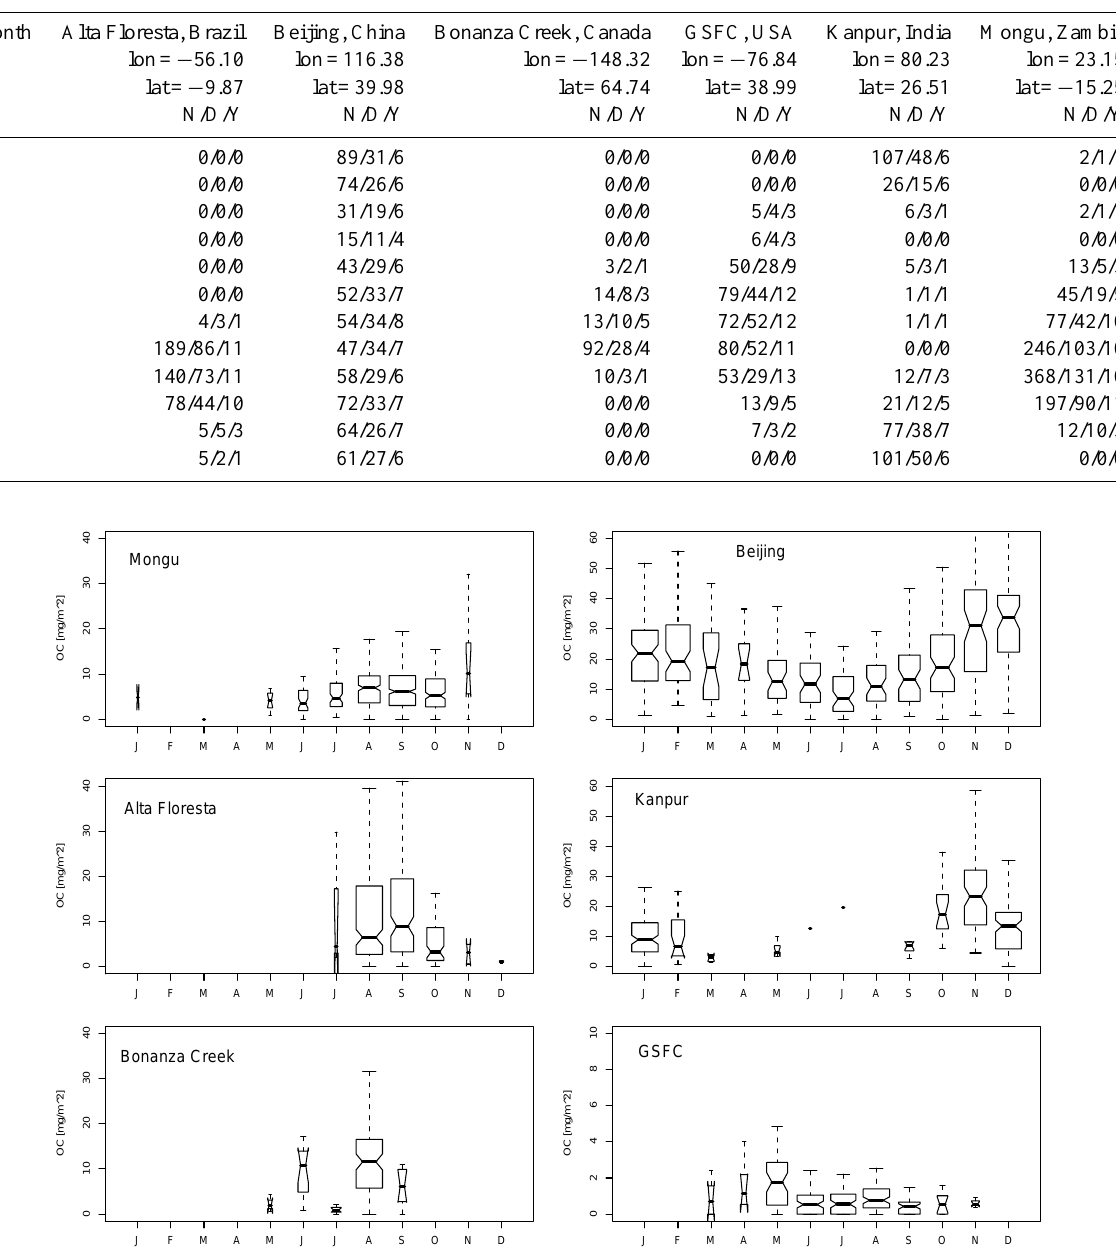
Table 2. Sites that were focused on in this study. For each month, information on the data volume is given; N=total number of retrievals, D=number of days having retrievals, Y=number of years having retrievals.